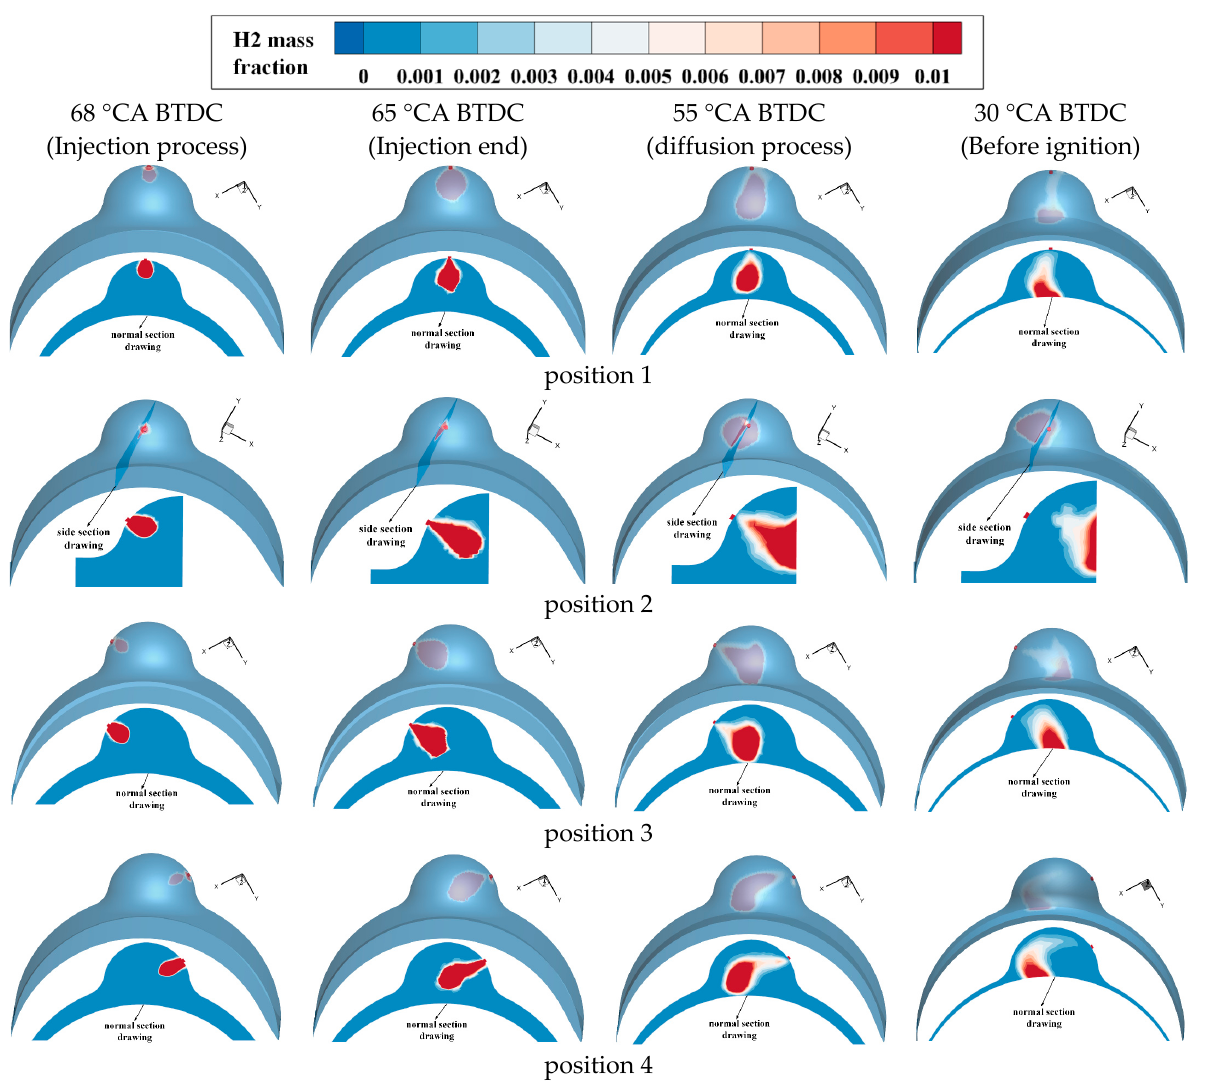
Figure 8. Comparison of hydrogen distribution in injection stage at different positions.